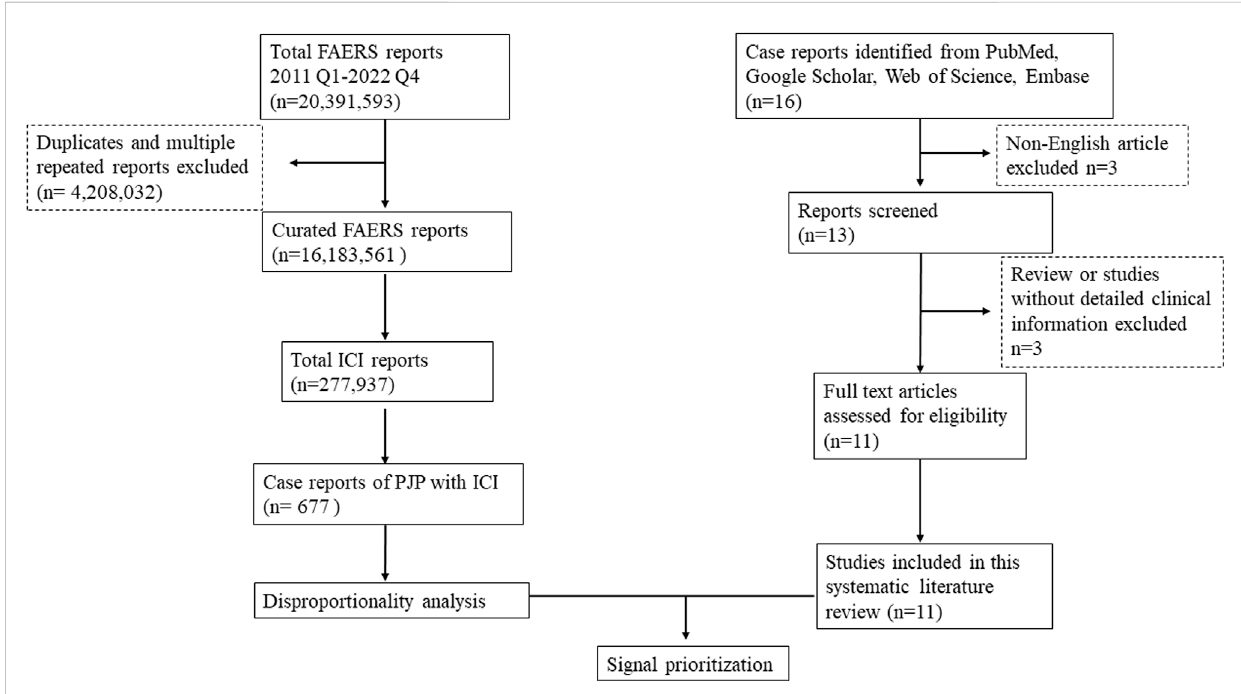
FIGURE 1 Flow chart to combine the FAERS disproportionality analysis with the systematic literature review. FAERS, FDA Adverse Event Reporting System; ICI, immune checkpoint inhibitor; Q1, quarter 1; PJP, Pneumocystis jirovecii pneumonia.